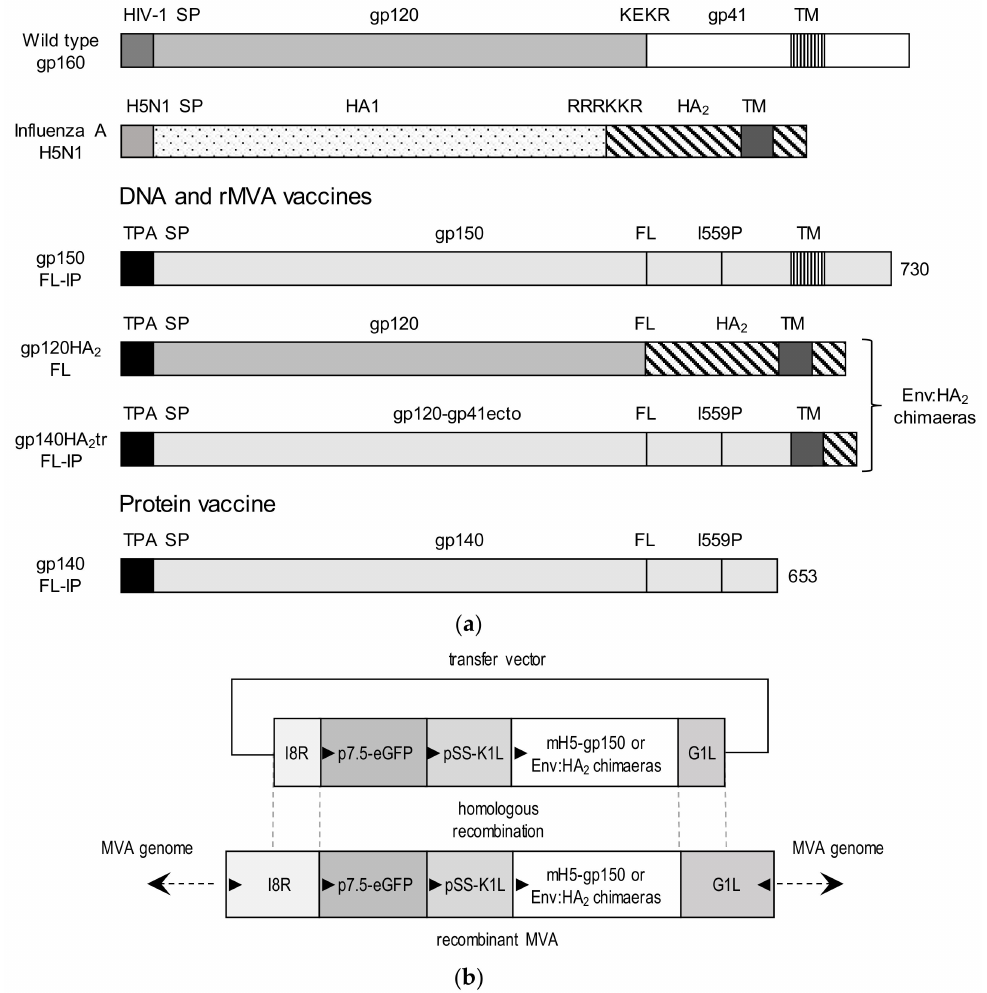
Figure 1. Design of DNA and modified vaccinia Ankara (MVA) vaccines expressing the chimeric envelope antigens. ( a ) Schematic representations of wildtype gp160, influenza hemagglutinin (HA), gp150-FL-IP, gp120HA 2 -FL, gp140HA 2 tr-FL-IP, and gp140-FL-IP. The gp160 sequence was truncated at amino acid residue 730 to generate gp150, the native signal peptide sequence (SP) was replaced